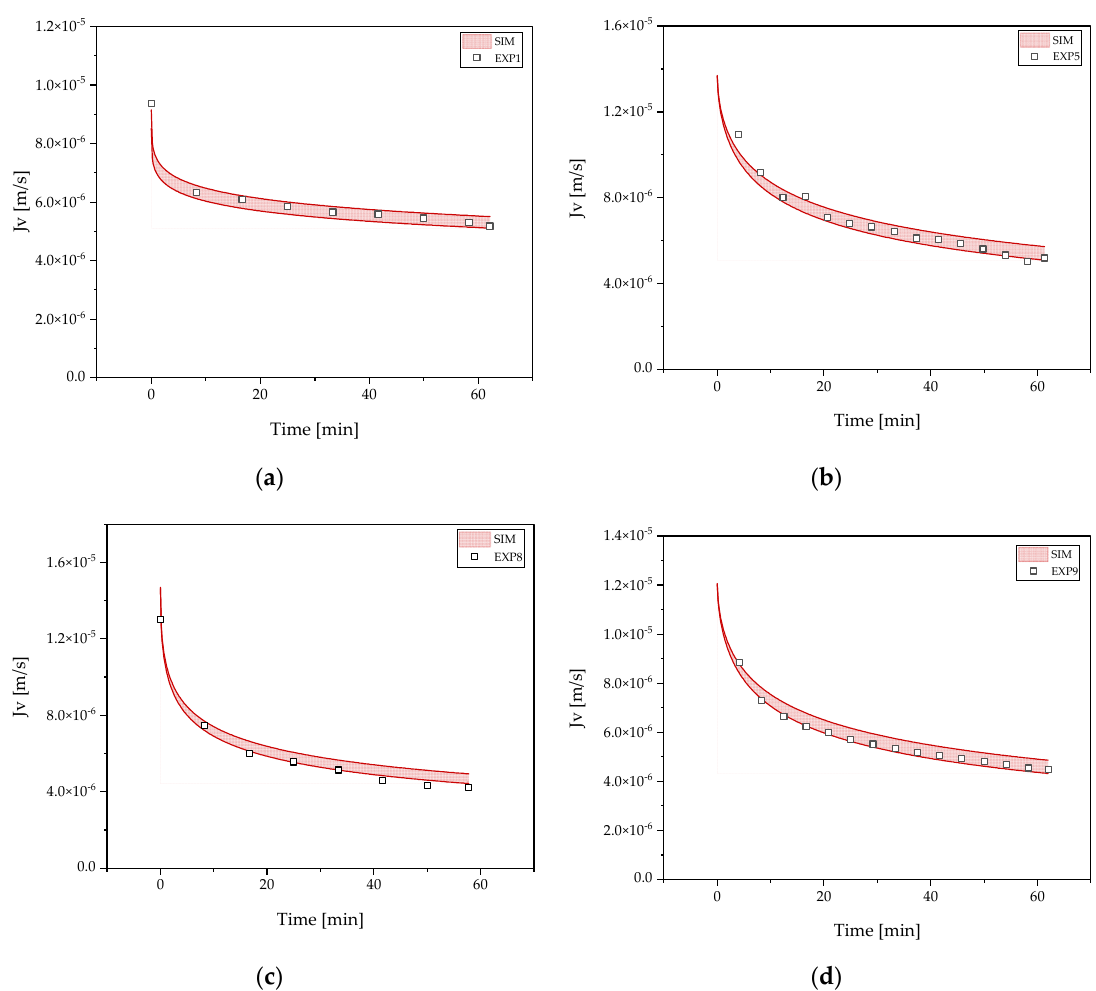
Figure 5. Flux Jv over time for experimental (squares) as well as digital twin prediction (red area) for harvest experiments by ultra-/diafiltration: ( a ) Experiment 1 (EXP1): 1.3 bar transmembrane pressure (TMP), 2040 s − 1 shear rate. ( b ) Experiment 5 (EXP5): 1.4 bar TMP, 11,285 s − 1 shear rate. ( c ): Experiment 8 (EXP8): 1.3 bar TMP, 6072 s − 1 shear rate. ( d ): Experiment 9 (EXP9): 0.8 bar TMP, 6028